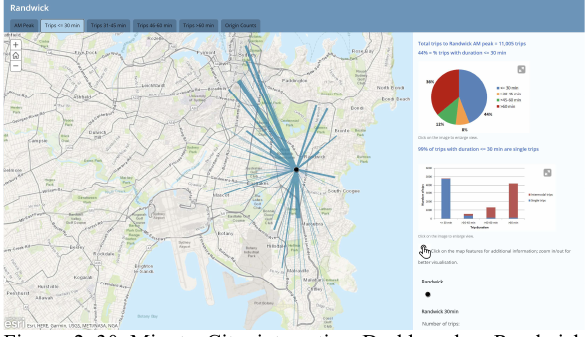
Figure 2 30 Minute City interactive Dashboard – Randwick precinct (https://cityfutures.be.unsw.edu.au/cityviz/-